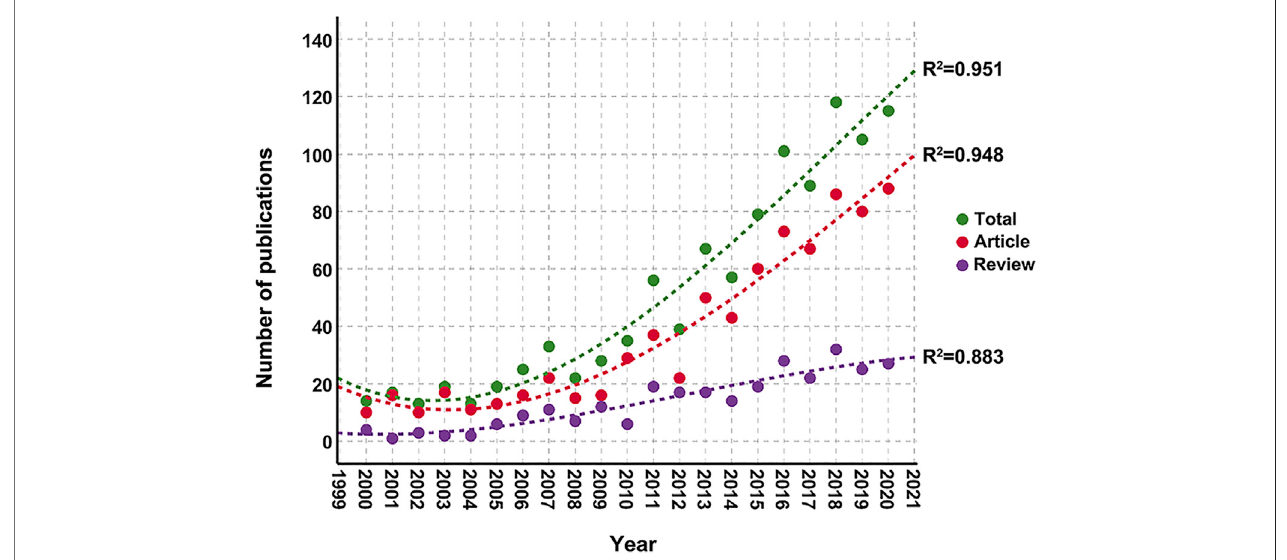
FIGURE4| AnnualtrendsinpublicationfromScopus(2000 – 2020)inthe fi eldofthekynureninepathway(KP)inmooddisordersandthecorrespondingpolynomial fi tted curves.